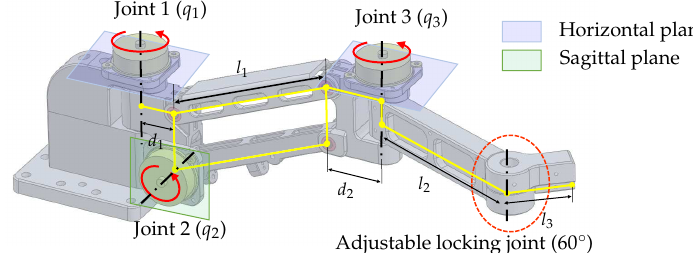
Figure 4. Configuration of the translational motion tracking structure.